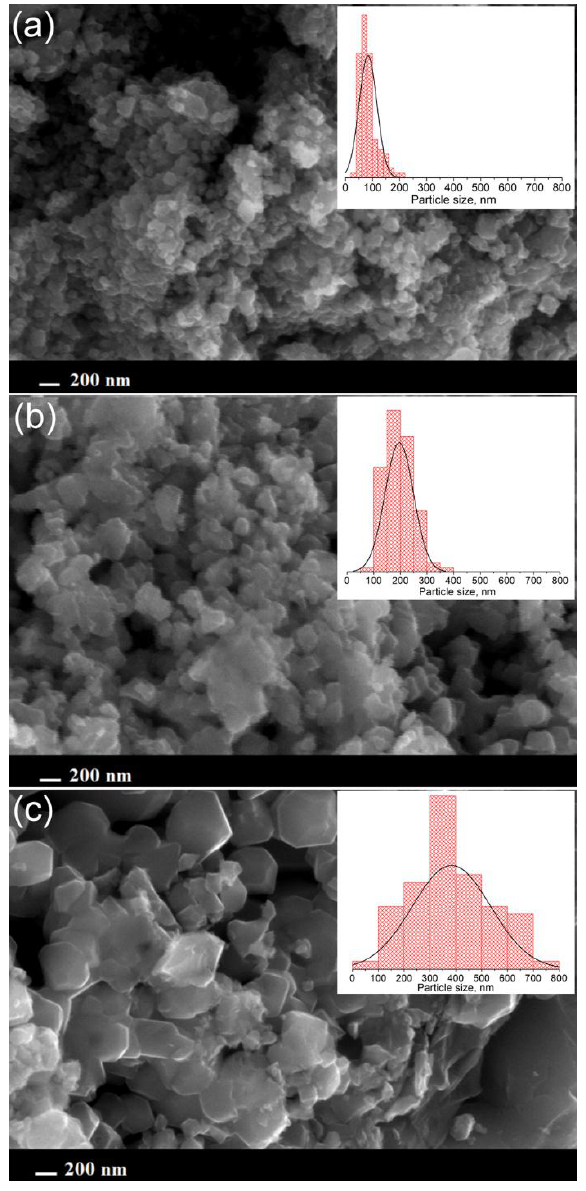
Figure 3. SEM micrographs of Li 1.1 Mn 1.95 Ni 0.025 Co 0.025 O 4 obtained by annealing at 600 °C ( a ), 700 °C ( b ) and 800 °C ( c ). The particle size distributions are shown on the insets.